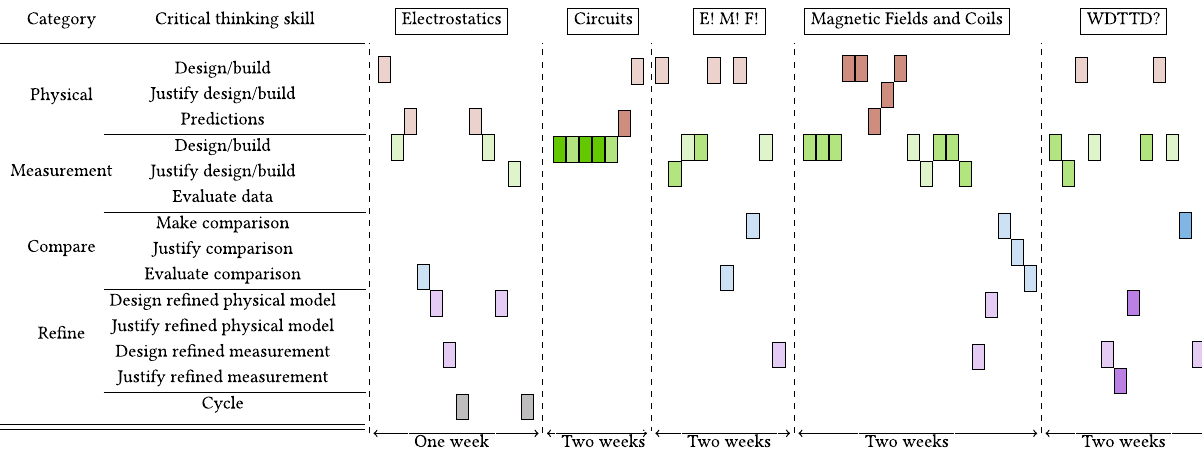
FIG. 6. Codes applied to semester 2 lab instructions ordered by the appearance of the code in the lab instructions, and lab activities are sequentially ordered. Colors correspond to the category of the code and shade provides the level of agency (less available agency identified by a darker